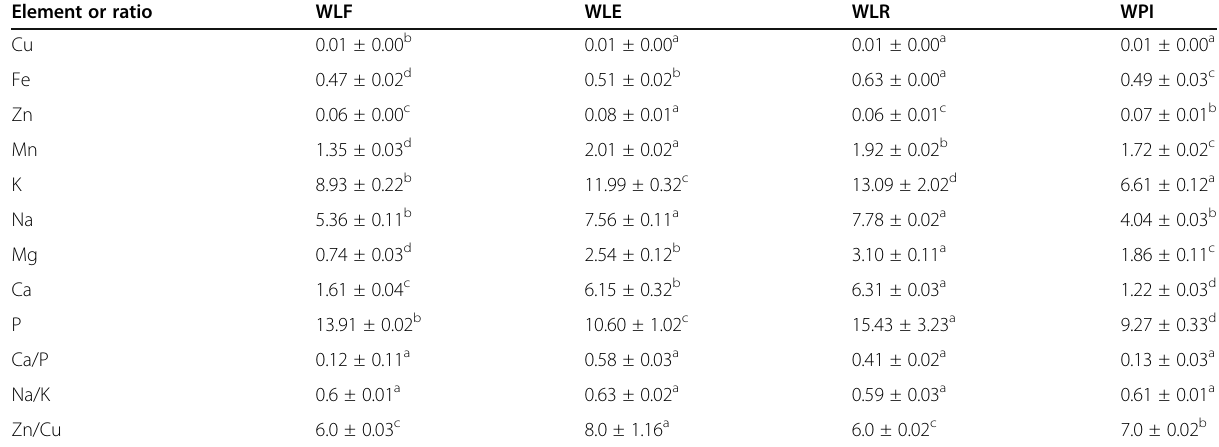
Table 2 Mineral composition of African wild lettuce leaves Element or